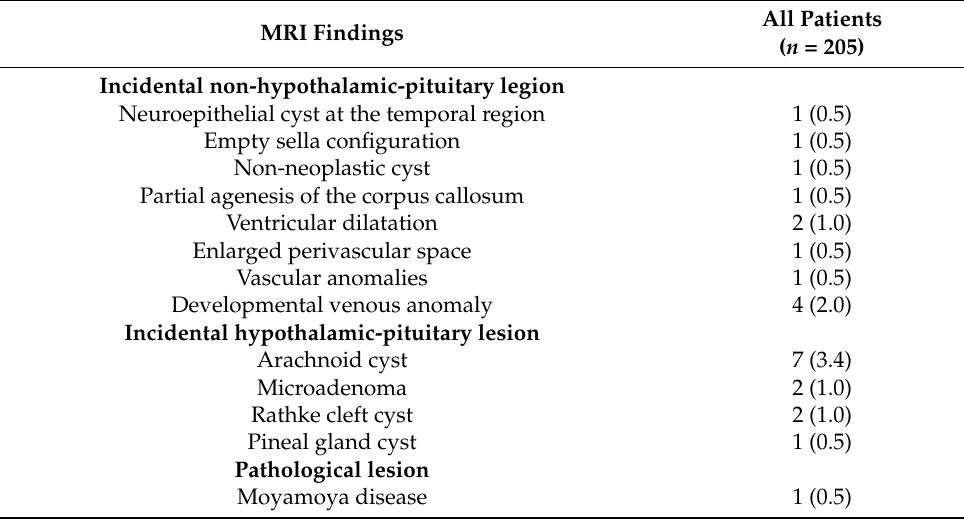
Table 2. Details of positive brain MRI findings of girls with chronic or recurrent